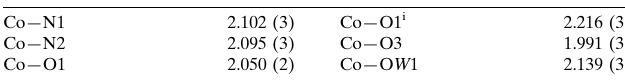
Selected bond lengths (A˚ ).